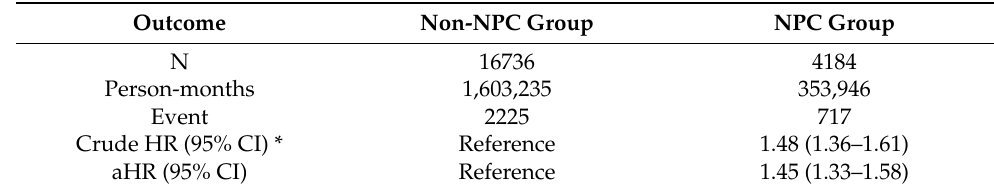
Study event between the nasal pharyngeal carcinoma and non-nasal pharyngeal carcinoma patients.